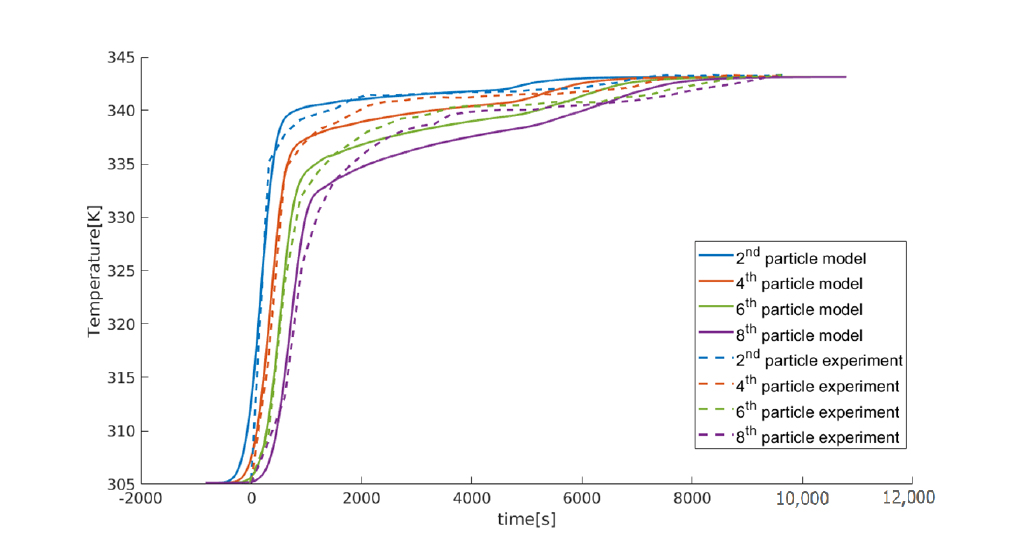
Figure 3. Comparison of the HTF temperature at different locations between the experiment [11] and numerical